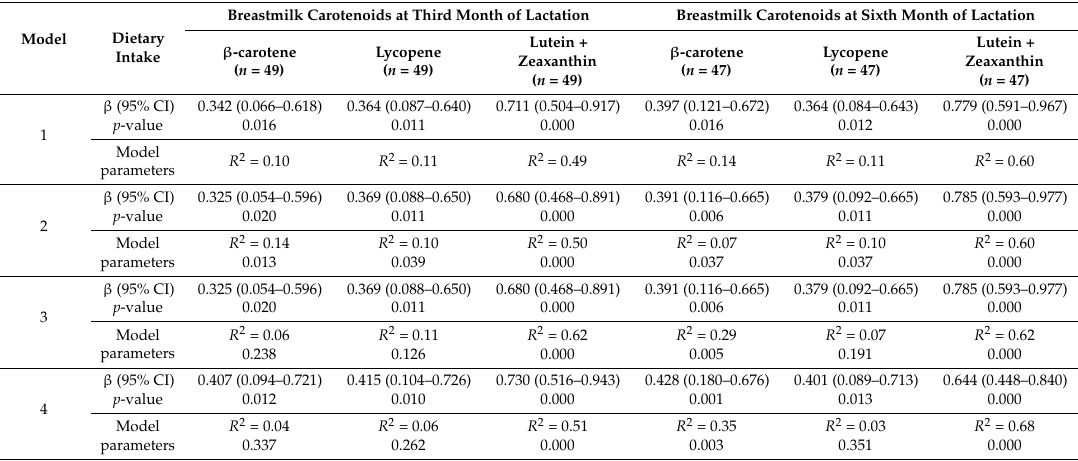
Table 5. Univariate and multivariate linear regression models between breastmilk carotenoids and dietary intake and third and sixth months of